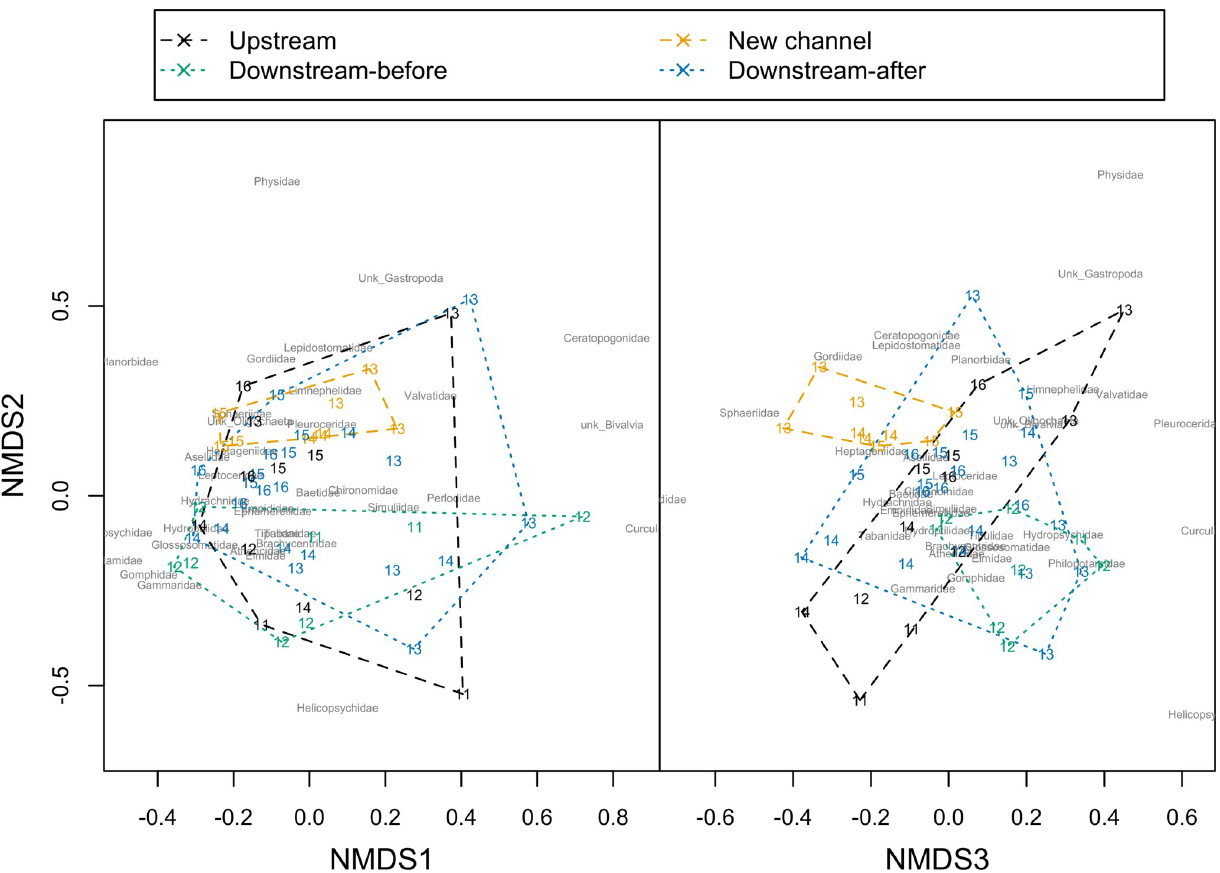
Fig 3. Non-metric multi-dimensional scaling (NMDS) ordination of stream macroinvertebrate community composition in the Boardman River, Michigan, (USA). 3-axis solution displayed (Stress: 0.17; Linear Fit R 2 = 0.83). Ordination hulls with distinct coloration highlight site categories, Site × Years displayed with the last 2 digits of the year of sampling. Chironomidae and Simuliidae were strongly associated with ordination axis 1. There was a weaker association of Lepidostomidae with ordination axis 2 and of Baetidae and Pleuroceridae with ordination axis 3.